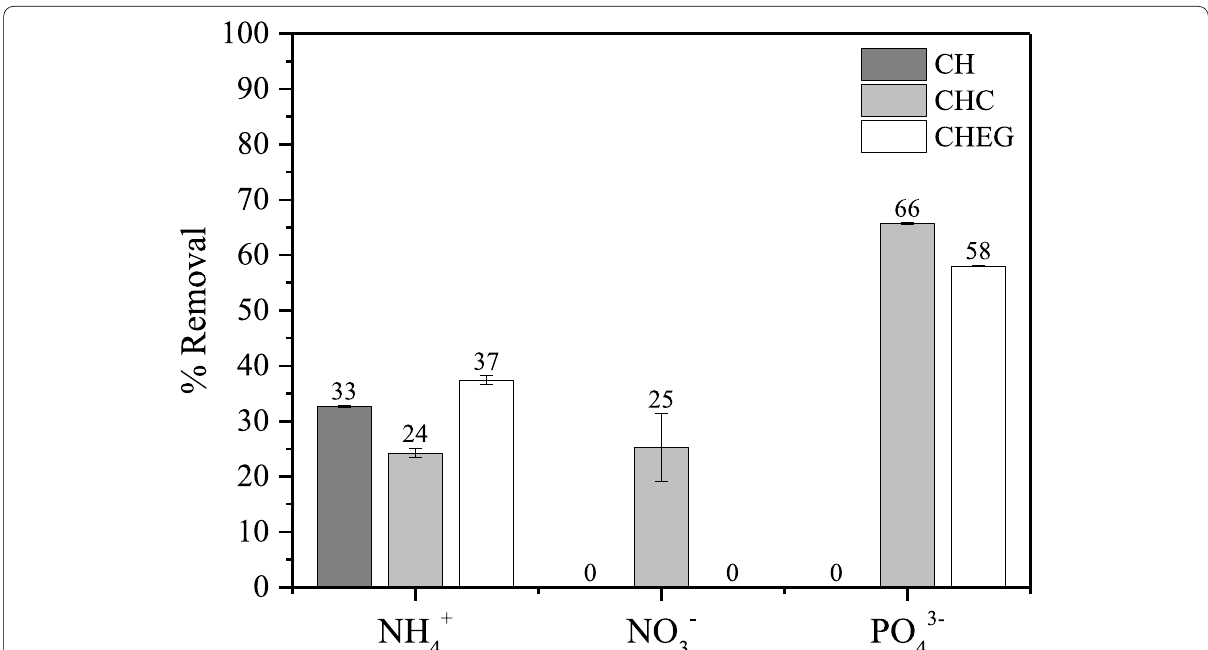
Fig. 9 The percentage of NH 4 + , NO 3 − , and PO 43 − removal by 20 g L − 1 of CH, CHC, and CHEG in sterilized surface water at time 48